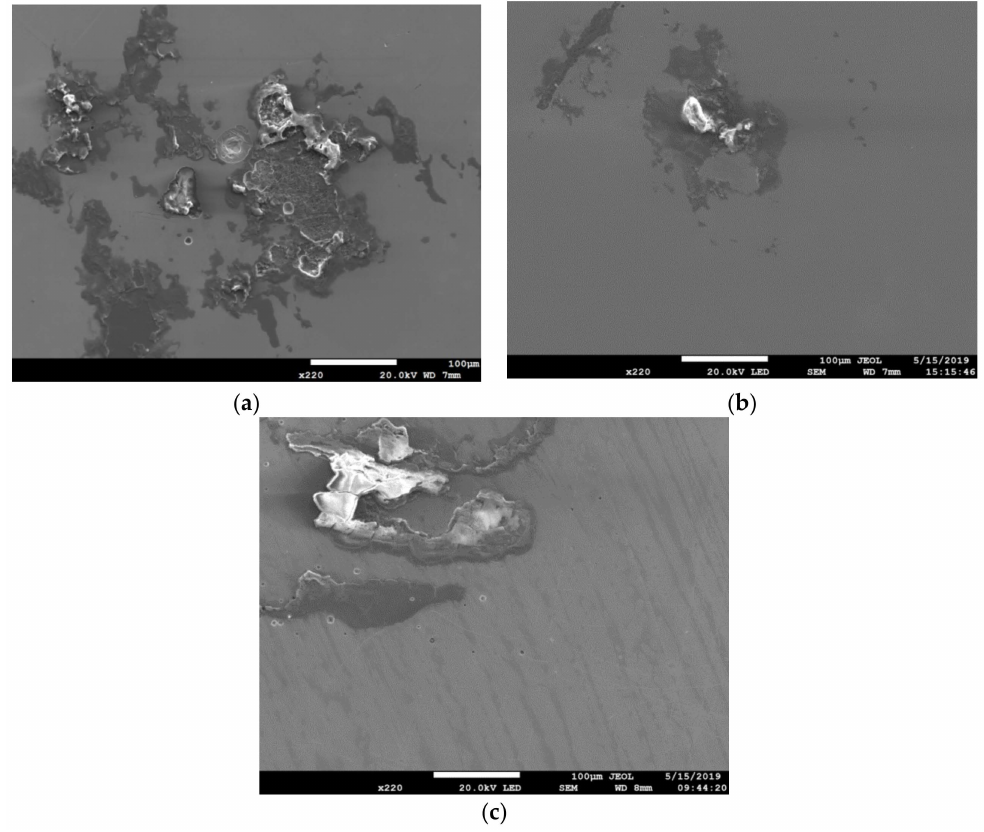
Figure 3. SEM morphologies of corrosion products after 5000 h tests with 0.1g / m 2 chloride